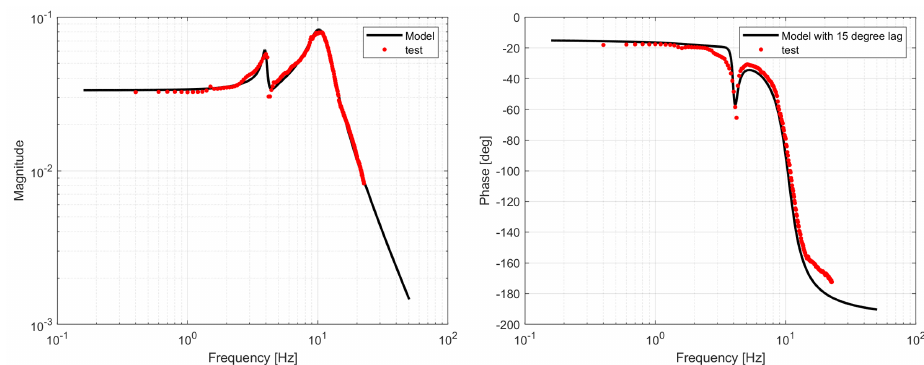
Figure 6. Bode plot of the system between the input force F ( s ) and the displacement X 1 ( s ) . The red dots are the measured data, and the black curve is the fitted model. The linear model phase is added an extra 15 ◦ lag to fit with the measured phase better.